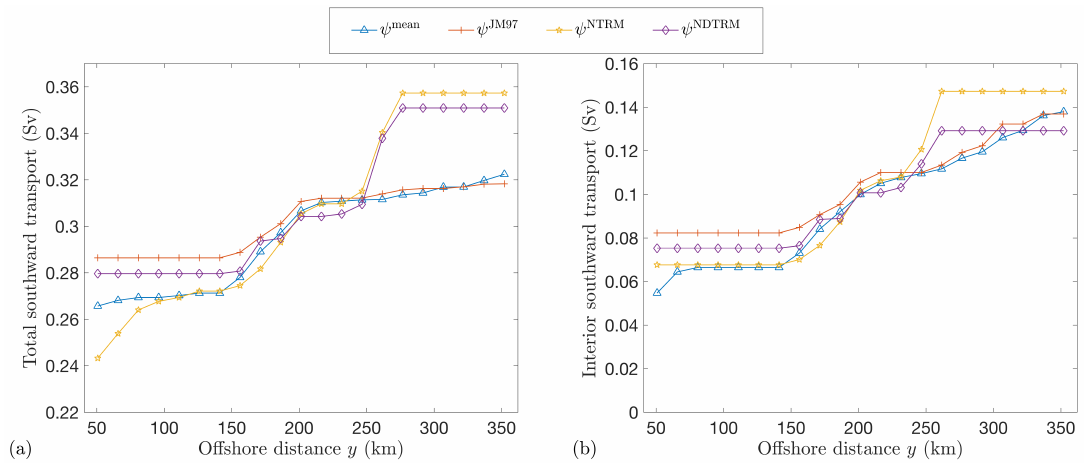
Figure 4. Comparison of total thickness-weighted average cross-slope transports calculated via TRM approximations vs. diagnosed directly from model output. ( a ) Total southward transport, ( b ) total interior southward transport, i.e., excluding wind-driven Ekman transport of surface waters (see Section 4 and